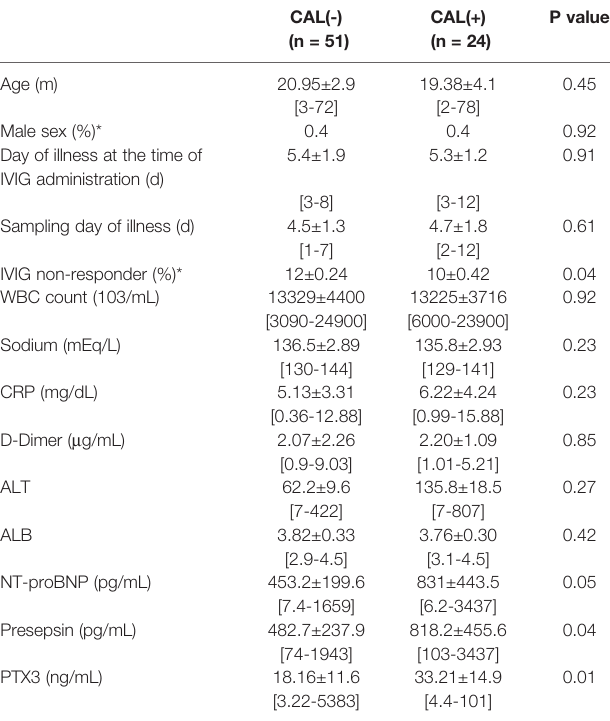
TABLE 2 | Demographic, laboratory characteristics of patients at the time of TABLE 3 | Demographic, laboratory characteristics of patients at the time of diagnosis in the groups without CAL and with CAL. diagnosis in the IVIG responsive group, and the IVIG resistant CAL(-) CAL(+)